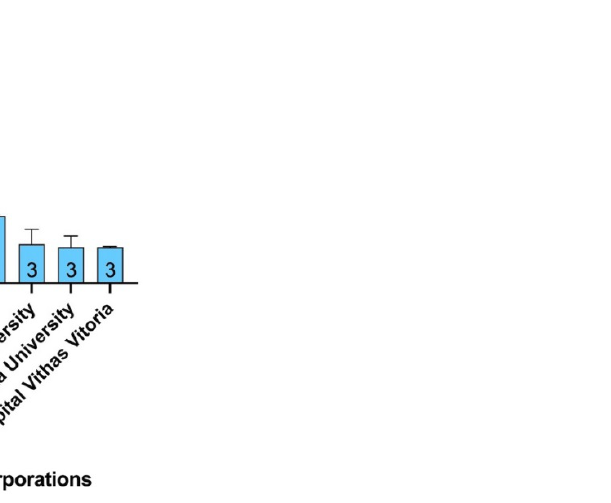
Figure 3. Geographic distribution of the top 100 most cited articles.